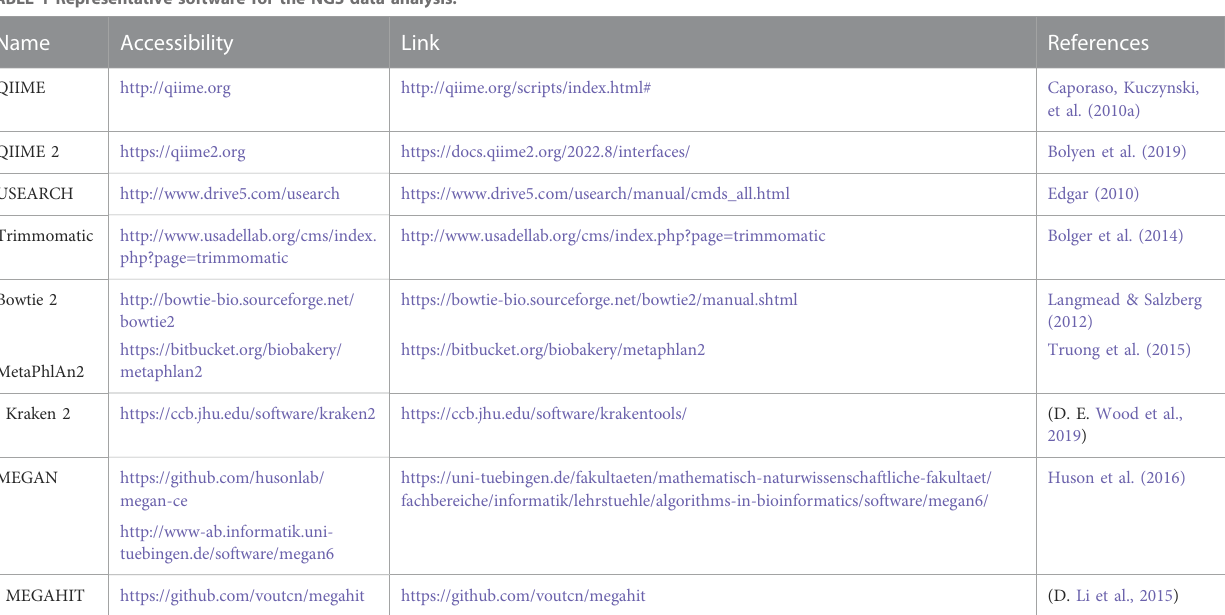
TABLE 1 Representative software for the NGS data